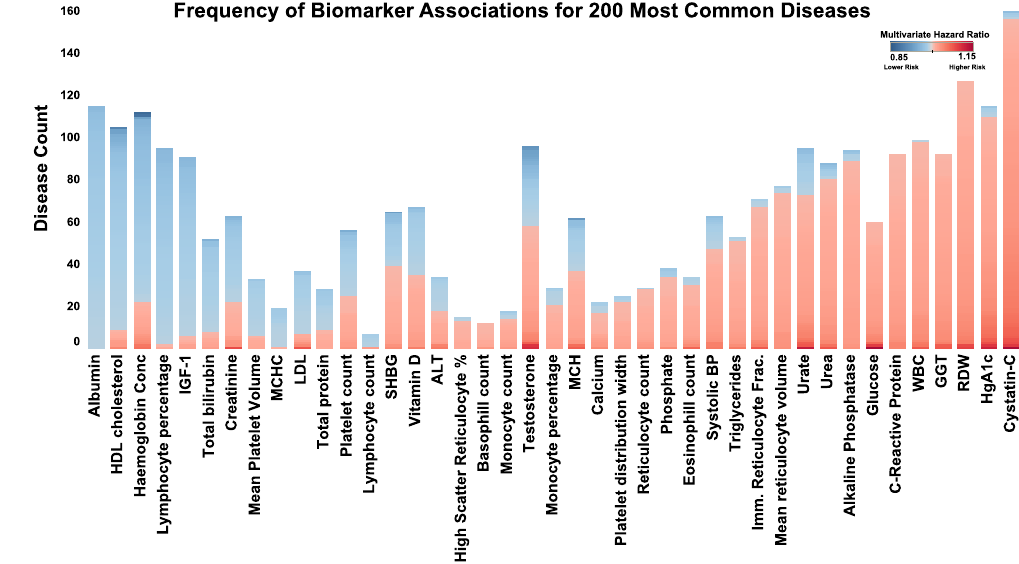
Figure 2. Frequency of increased (red) and reduced risk (blue) association for biomarkers across most prevalent diseases in UK Biobank (associations ≥ 0.01 were considered for this figure). The bars are sorted by sum of the coefficients, so that the biomarkers that have cumulatively low hazard are on left, cumulatively high hazard on the right, and the mixed patterns are in the middle. ALT alanine amino tansferase, MCH mean